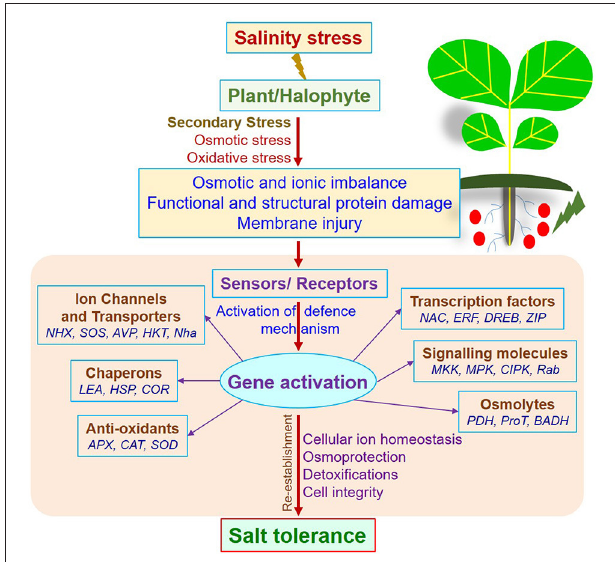
FIGURE 1 | A generalized schematic representation of salinity stress tolerance mechanism in a